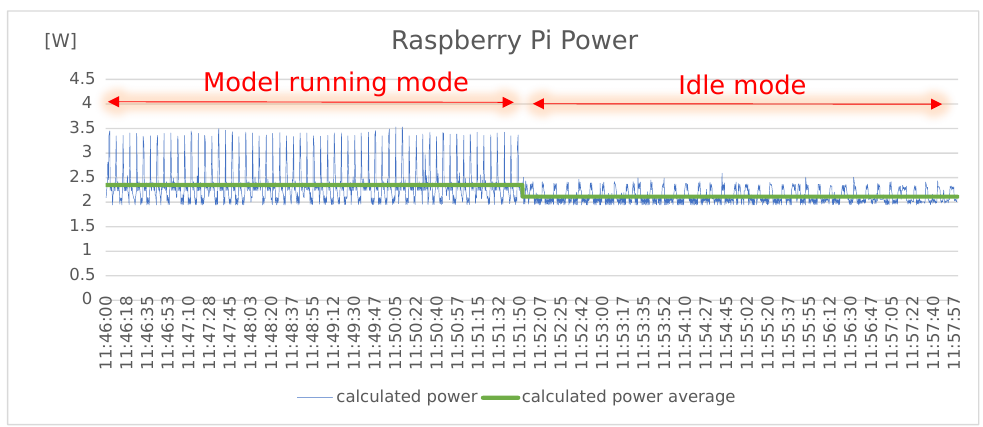
Figure 17. Variation in current consumption for ML model in Jetson; (y → power [W], x → time).